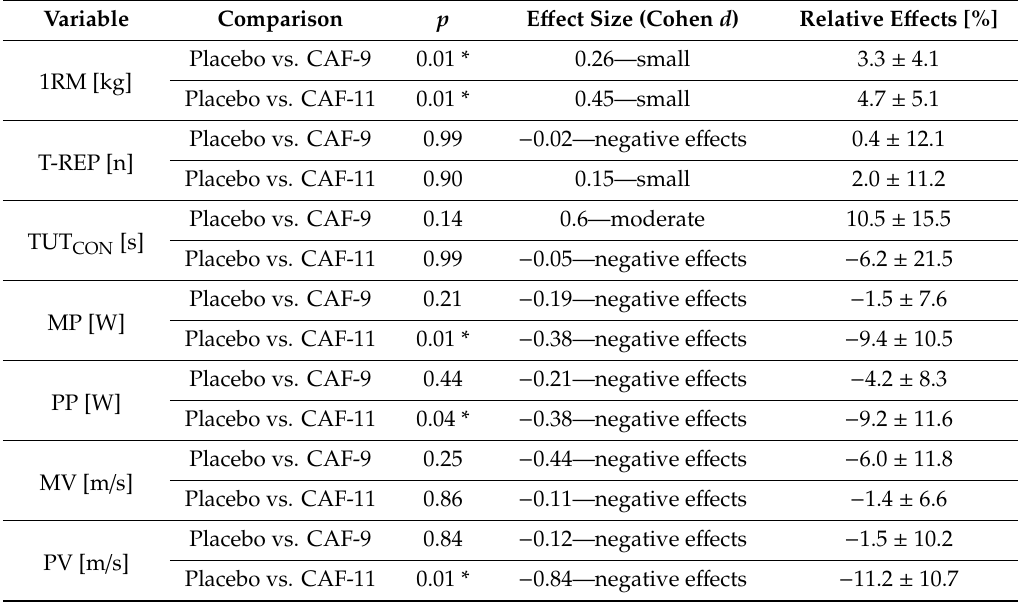
Table 2. Di ff erences in placebo vs. ca ff eine conditions between experimental